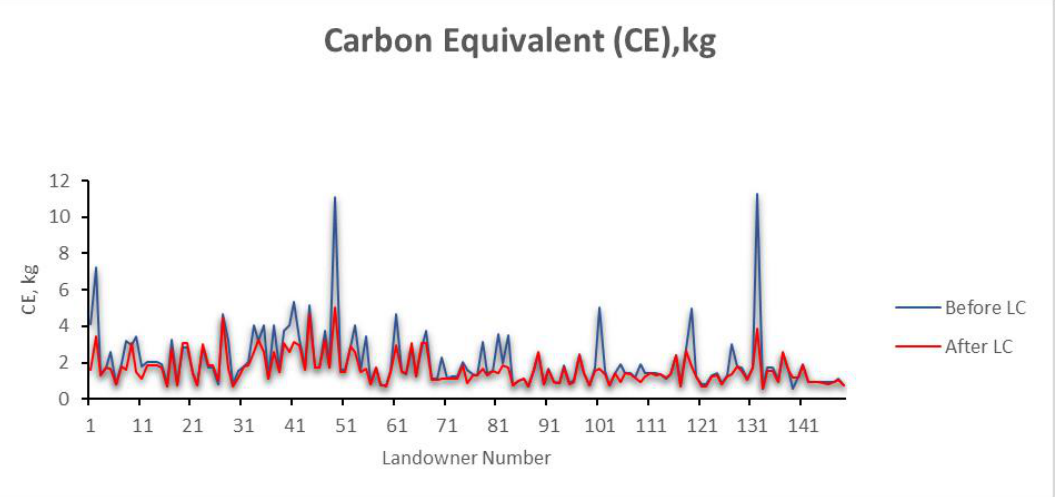
Figure 5. Changes in the carbon footprint values on individual farms as a result of land consolidation (Fatih Neighborhood).